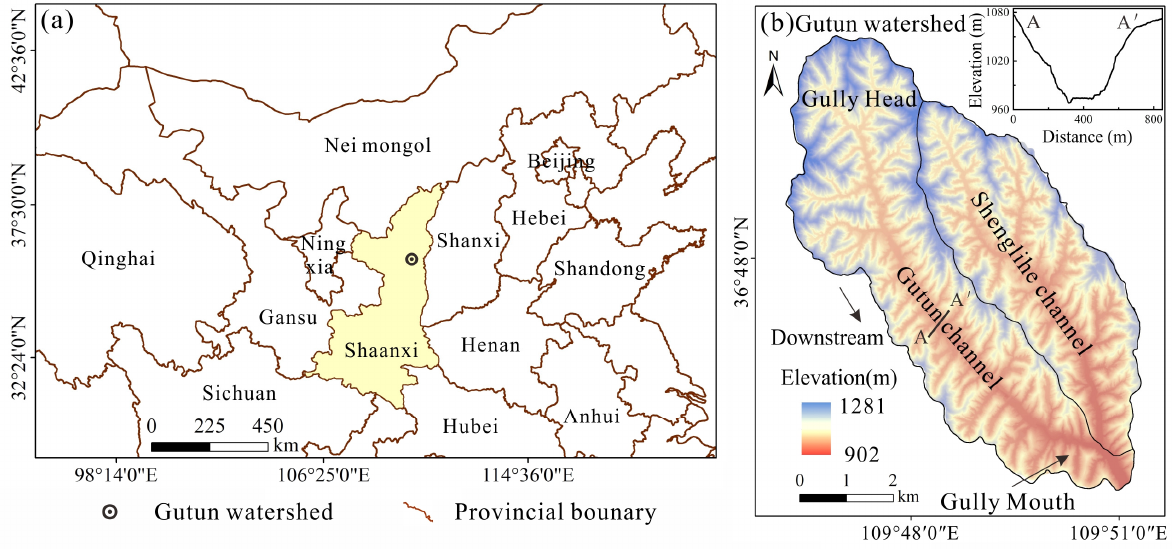
Figure 2. Location of the study area. ( a ) Location of the study area in Shaanxi Province; ( b ) topography of the Gutun watershed, including the two main channels of the Gutun and Shenglihe. The illustration in the upper right corner shows the topography of the A–A’ profile.